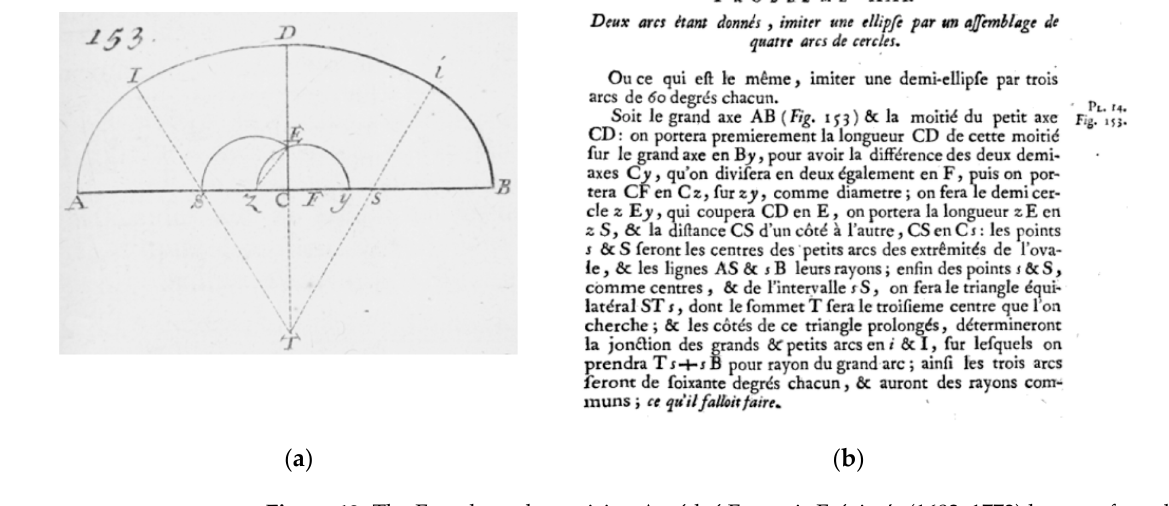
Figure 12. The French mathematician Amédeé François Frézier’s (1682–1773) layout of a polycentric oval inscribed in a rectangle with the third parameter defined as specific 60° angles that the centres of the arcs form when aligned with the major axes. Frézier’s approach is finding the centre of the minor arc first and creating the 60° angle from there (Frezier 1737–1739, Fig.153, Pl.14).